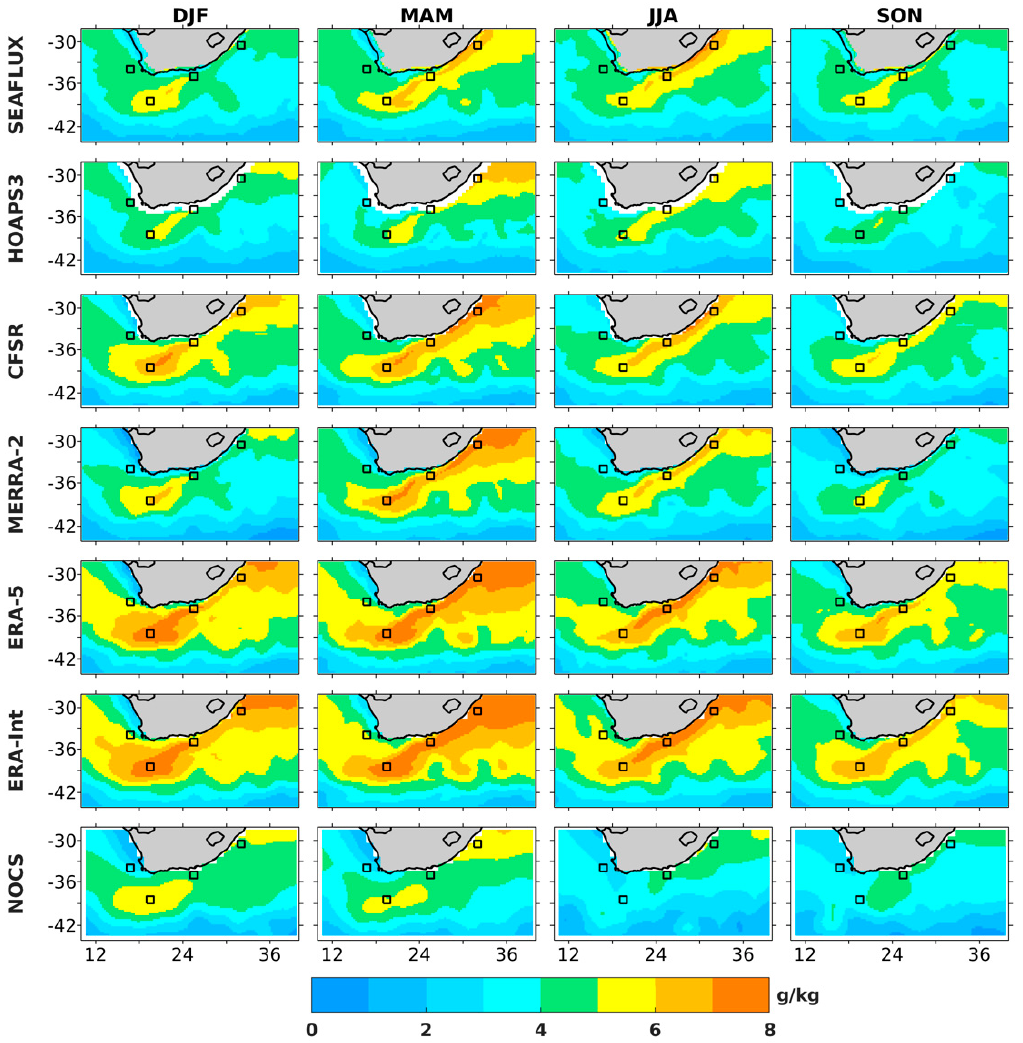
Figure 13 : Mean seasonal differences between surface specific humidity and specific humidity of air (Qss-Qa, g/kg) for SEAFLUX, HOAPS3, CFSR, MERRA-2, ERA-Interim and NOCS. From left to right austral summer (DJF), austral autumn (MAM), austral winter (JJA) and austral spring (SON). Black squares represent the four locations of the study. The products have been interpolated on the grid of SEAFLUX (0.25° × 0.25°).